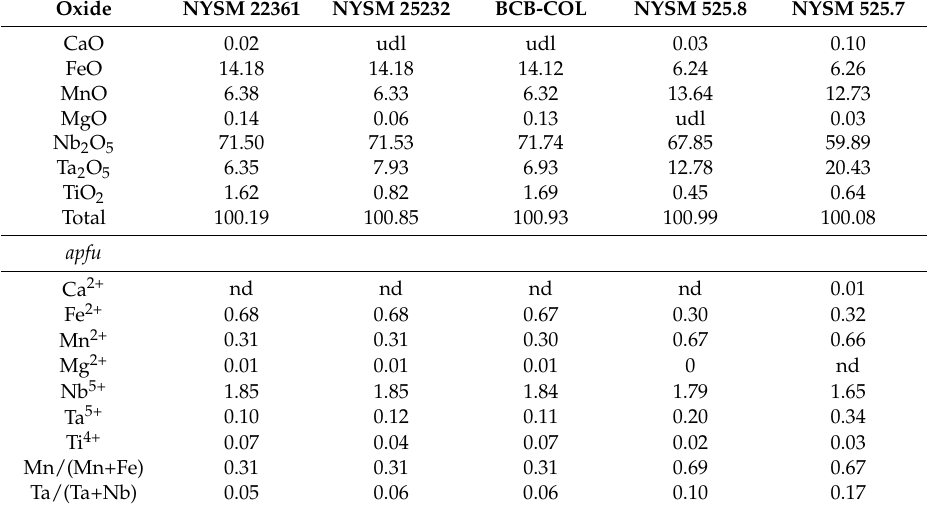
Table 1. Electron microprobe data of the columbite-group minerals from southern New York (wt. %). Oxide